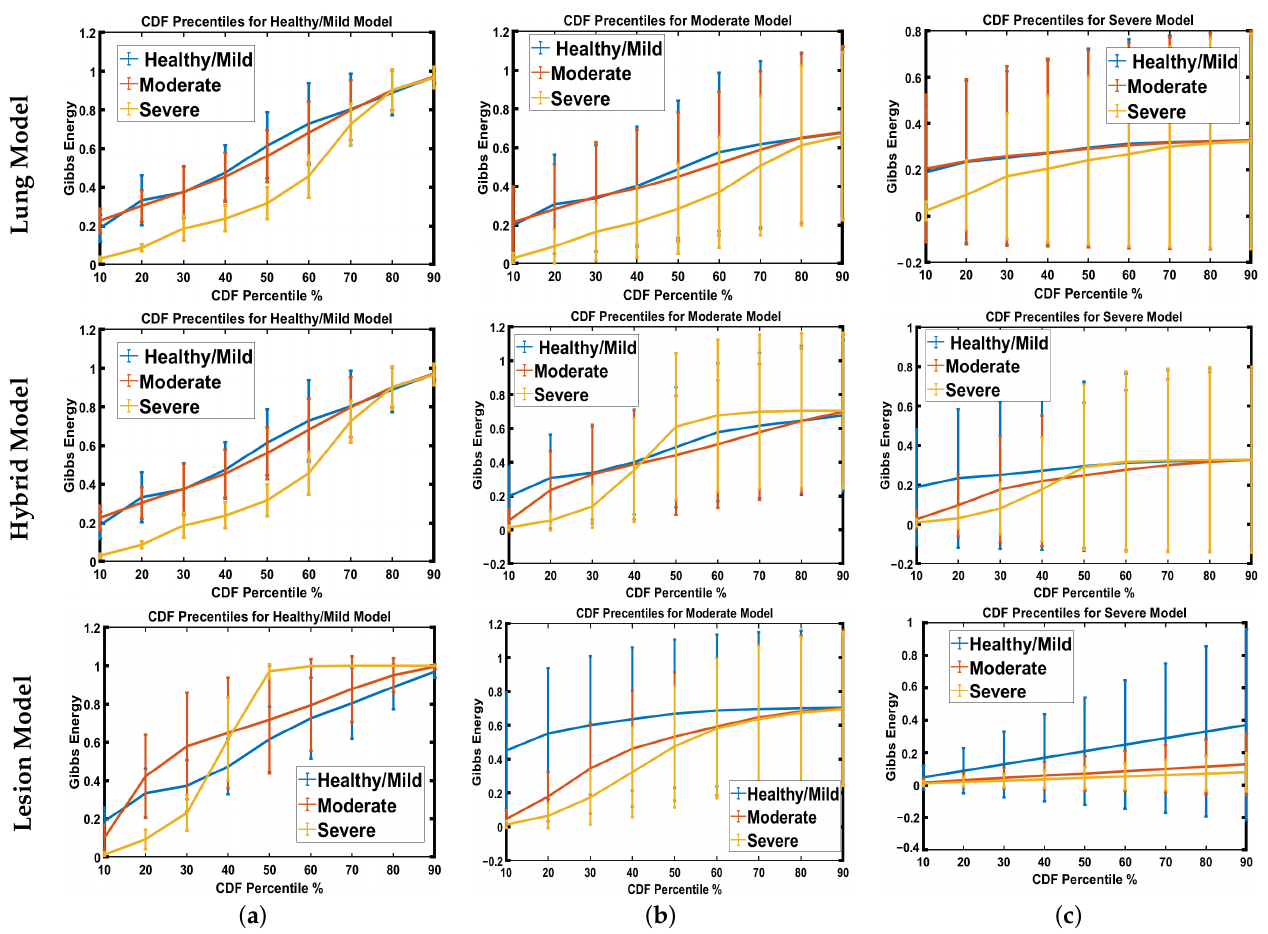
Figure 7. Estimated error average of CDF percentiles for three grades when tuning MGRF parameters using ( a ) healthy/mild, ( b ) moderate, or ( c ) severe lesion infection, applied to lung (upper row), hybrid (middle row), and lesion (lower row)